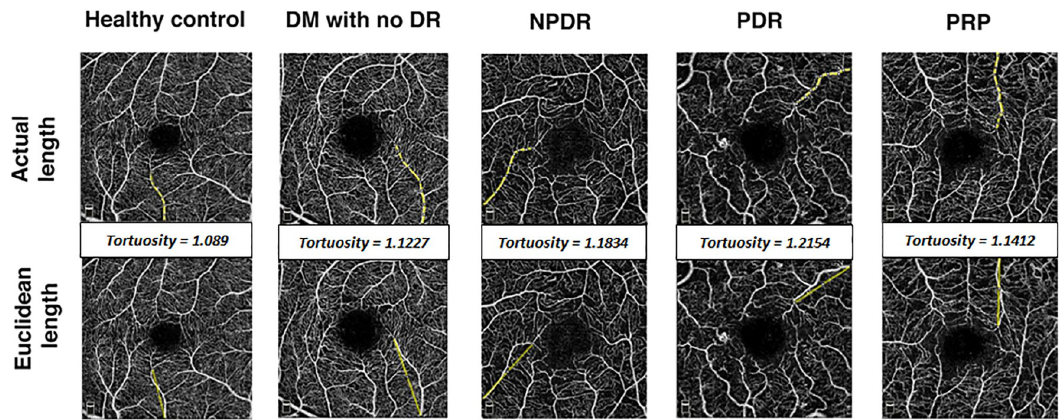
Fig 1. Calculation of vessel tortuosity. 3x3 mm OCTA scans segmented to show the SCP (inner boundary at the ILM and the outer boundary 10 μ m above the IPL). The actual and Euclidean lengths are measured for every individual branch and vessel tortuosity is calculated as the ratio between the sum of the actual lengths of all branches and the sum of their Euclidean